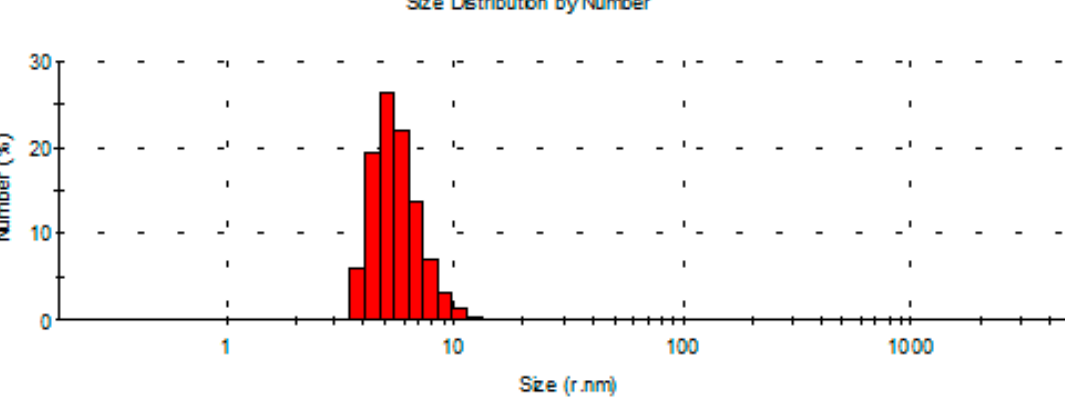
Figure 5. Size distribution of a solution of AgNPs (diluted 1:4) obtained with AgNO 3 solution 350 µ M in 50 mM in phosphate buffer (PBS) buffer of pH 7.